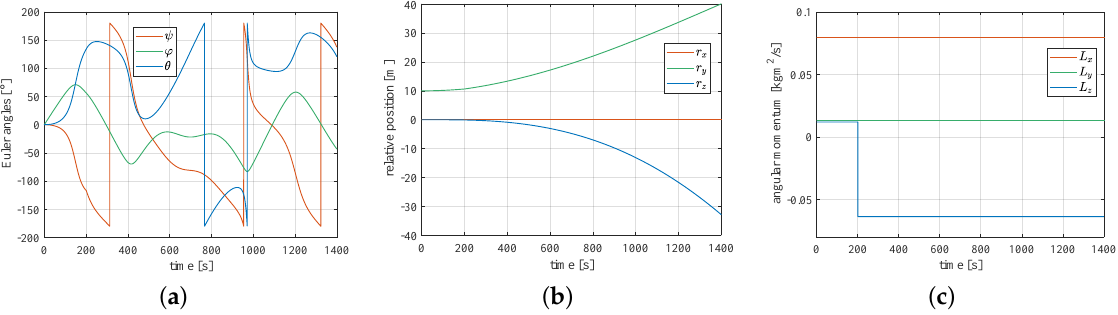
Figure 4. The true values of the Euler angles, the relative position, and the angular momentum of the defunct space object: ( a ) true values of the Euler angles; ( b ) true value of the relative position; ( c ) true value of the angular